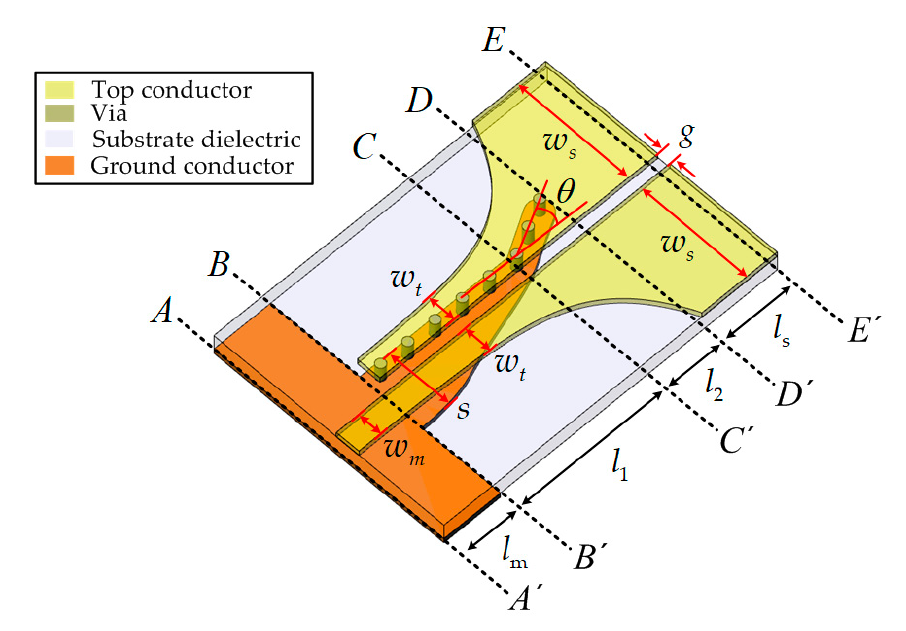
Figure 1. Proposed microstrip-to-slotline transition configuration.